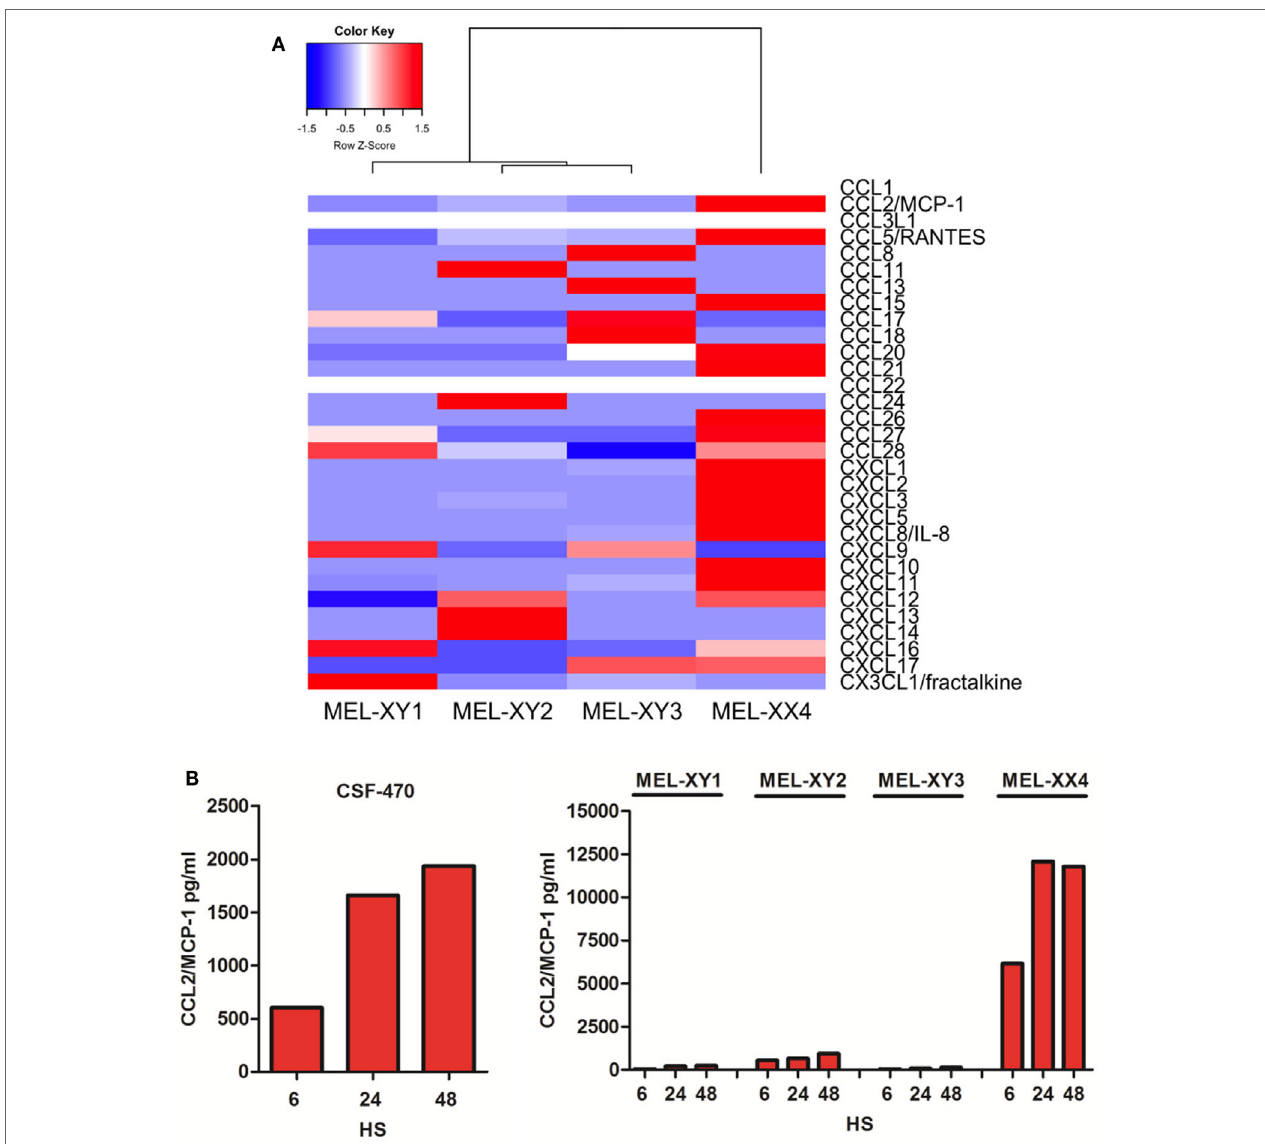
FigUre 3 | Chemokine expression profile of cutaneous melanoma cell lines components of CSF-470 vaccine. (a) Chemokines expression by non-irradiated MEL-XY1, MEL-XY2, MEL-XY3, and MEL-XX4 cells by RNAseq. Transcript abundance for each cell line is shown as fragments per kilobase of exon per million fragments mapped. (B) CCL2/MCP-1 protein expression at 6, 24, and 48 h supernatants from CSF-470 vaccine cells and each irradiated cell